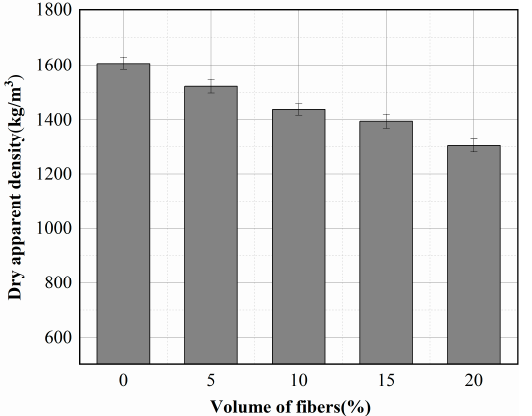
Figure 4. Apparent density of specimens with different fiber contents.